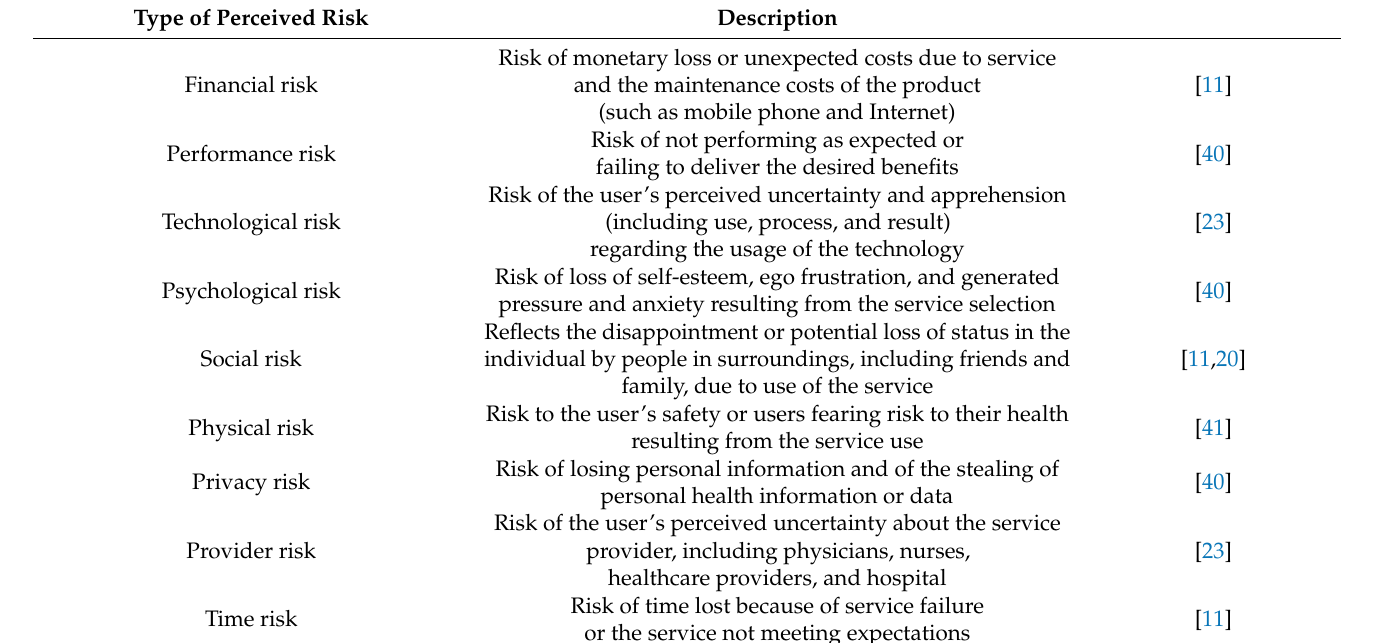
Table 1. Description of the types of perceived risk.